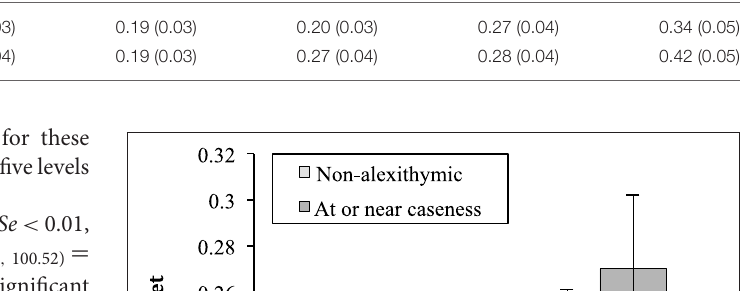
Non-alexithymia